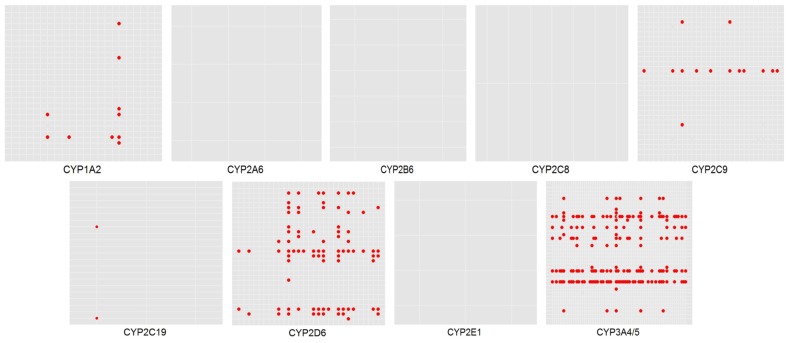
DDI enrichment plots among 9 CYP enzymes.Both x- and y-axis represent different drug names from a DDI pair. A red-dot highlights a DDI pair showing a strong association with myopathy risk (p<0.0000136, odds ratio>1).